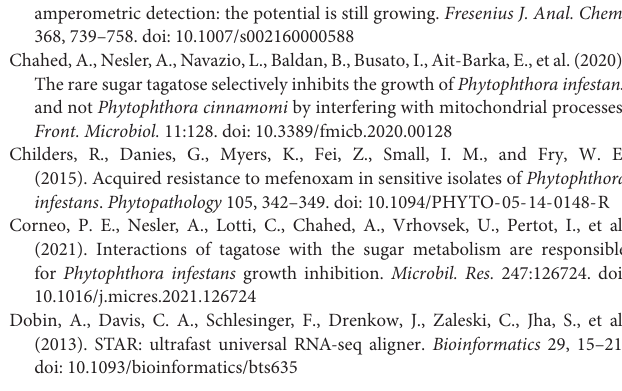
Supplementary Figure 2 | Effect of tagatose on Phytophthora spp. amino acid content. Supplementary Figure 3 | Correlation matrixes of Phytophthora infestans control samples at 4 days after incubation. Supplementary Figure 4 | Correlation matrixes of P. infestans control samples at 10 days after incubation.